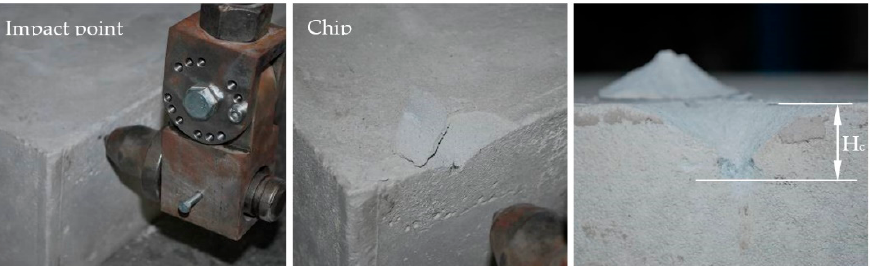
Figure 3. Calculation of the cutting depth as a function of the impact point of the pick on the mate- rial.